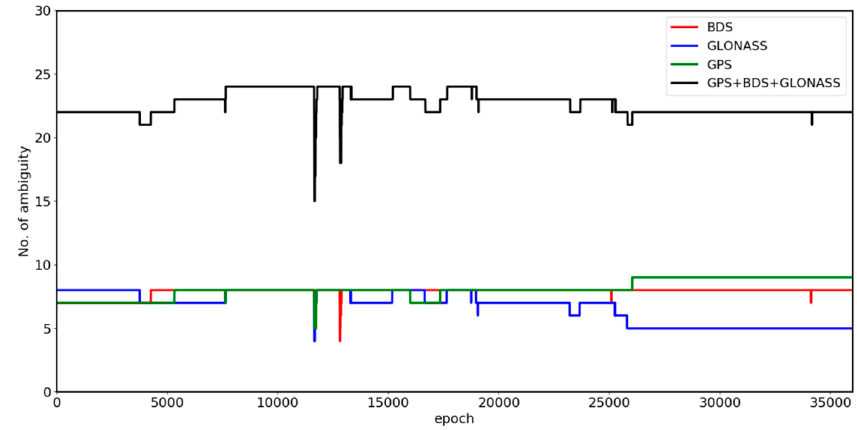
Figure 3. Satellite number of the S012 experiment.